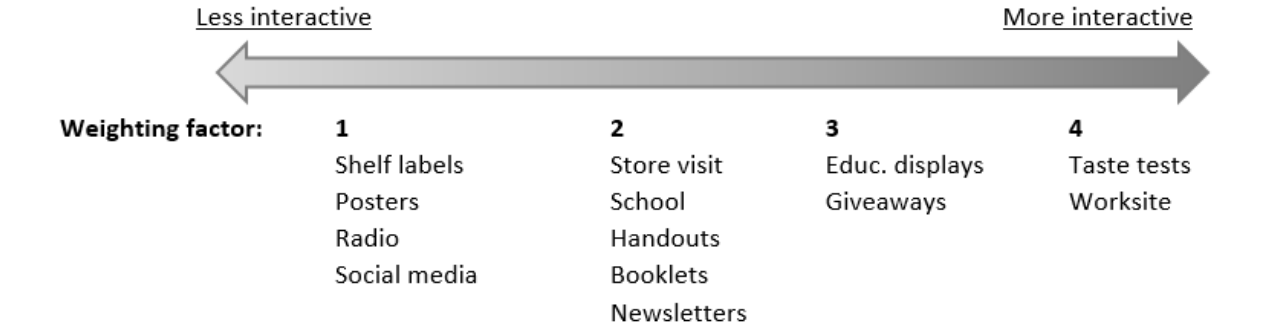
Figure 1. Continuum of interaction/engagement within intervention components, with corresponding factors (one to four) used in the weighting scheme.